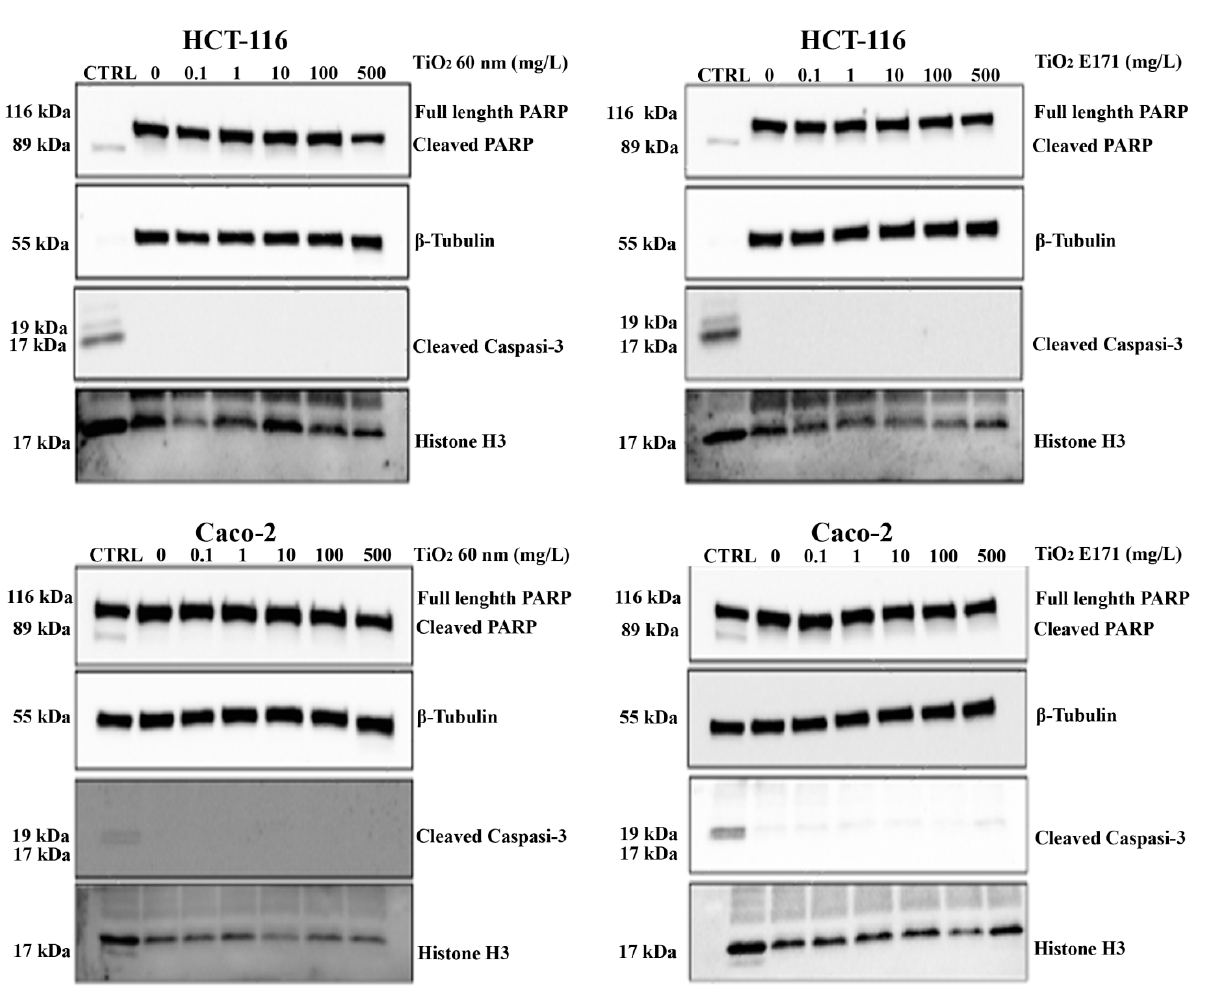
Figure 4. Representative images of apoptotic markers in colon cancer cell lines (HCT-116 and Caco-2) after 72 h exposure to E171 or TiO 2 60 nm.